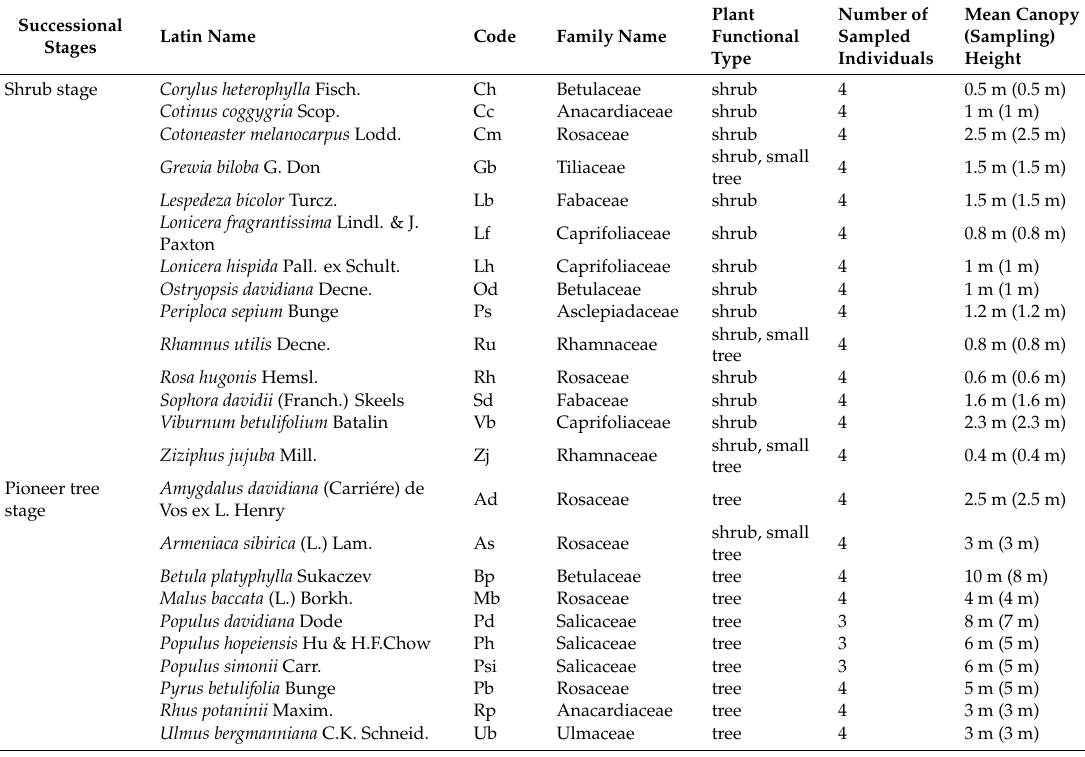
Table 1. List of 31 woody species tested in the present